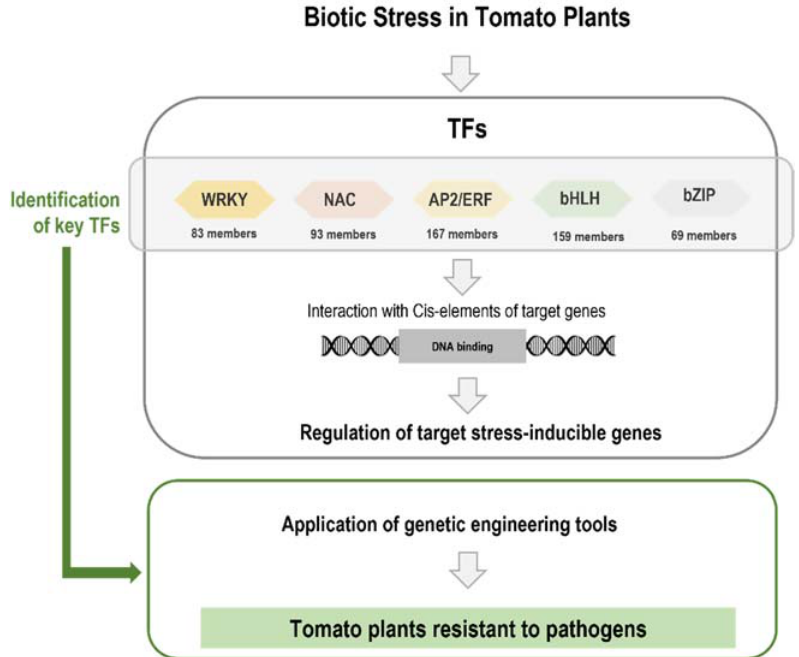
Figure 2. Tomato transcription factors (TFs) as key components of the regulation of target gene expres- sion in response to biotic stress and their use for engineering pathogen resistance in tomato plants.